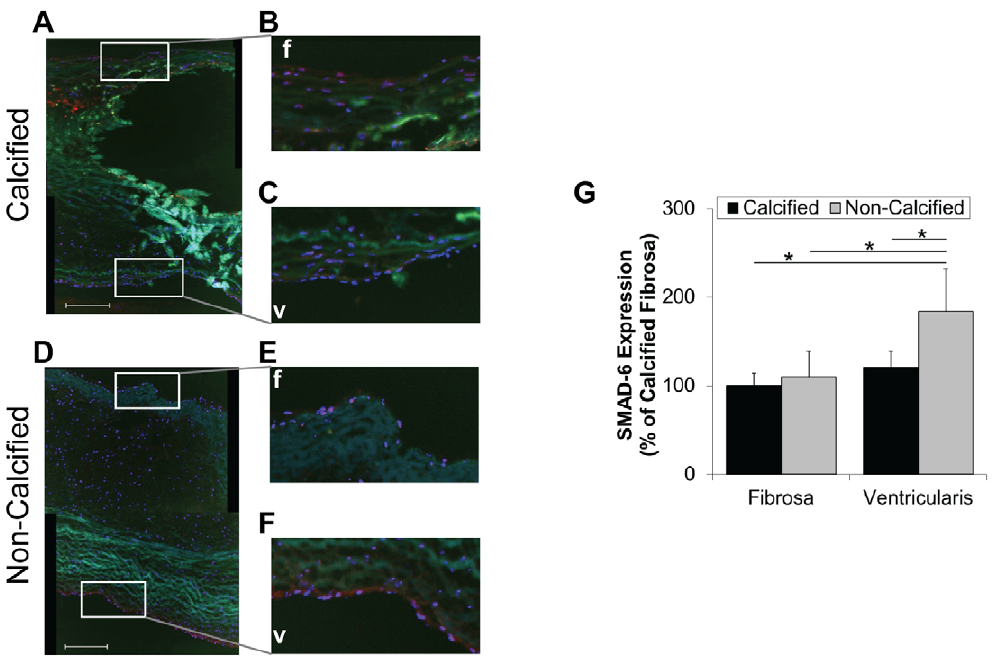
Figure 5. SMAD-6 expression in the fibrosa and ventricularis endothelium. Calcified and non-calcified AV sections were stained for SMAD-6, and a rhodamine-labeled secondary antibody. Shown are representative images. Bar graphs show staining intensities of fibrosa- and ventricularis- endothelium for each antagonist ( G ) (mean + SEM). For SMAD-6, n=22 calcified and n=15 non-calcified. *p , 0.05, # p , 0.06. f: fibrosa, v: ventricularis.